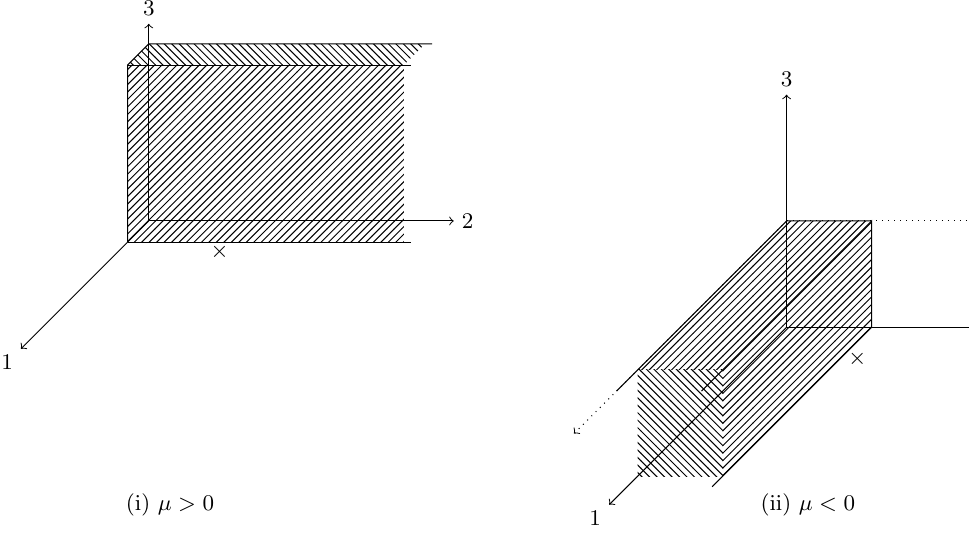
Figure 8 . The left (cid:12)gure shows (cid:22) > 0 case where asymptotic Young diagram is ( (cid:22) ). The right one shows (cid:22) < 0 case. The origin is moved to the x 3 direction and asymptotic Young diagram is ( j (cid:22) j ; j (cid:22) j